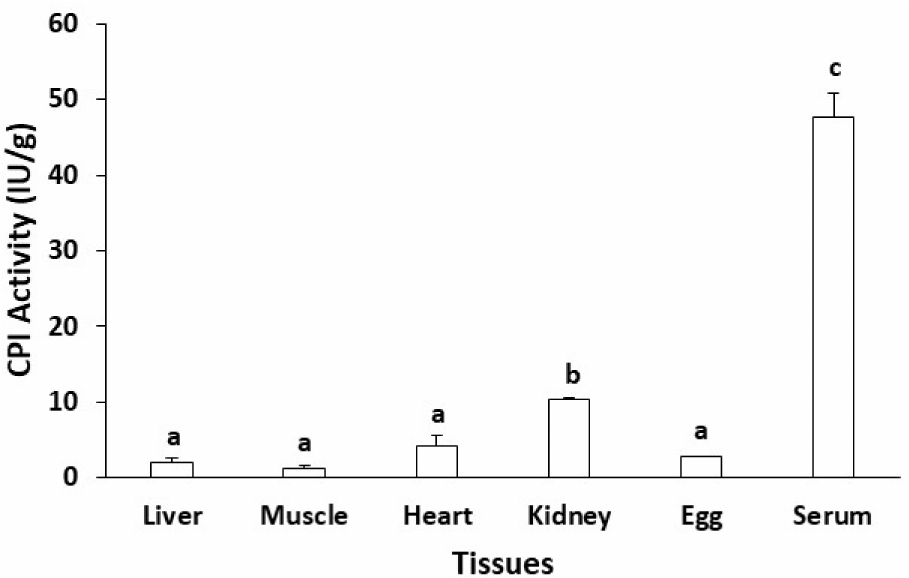
Figure 2. Differential activity of CPI in various tissues of Nile tilapia Oreochromis niloticus . Different letters on top of each column indicate significant difference in CPI activity between tissues (Tukey’s multiple comparison, p <